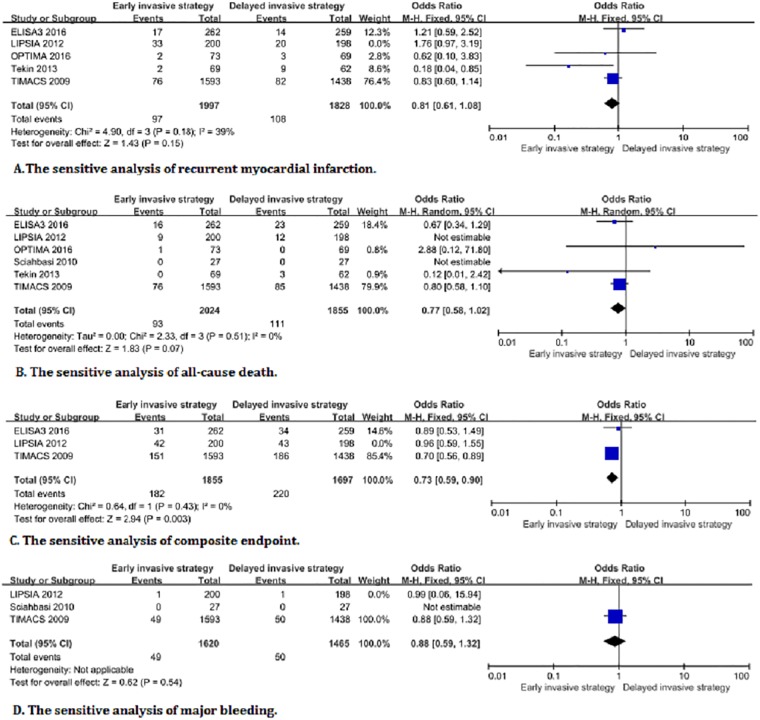
The sensitive analysis excluding the LIPSIA trial on related endpoints between early and delayed invasive strategies.